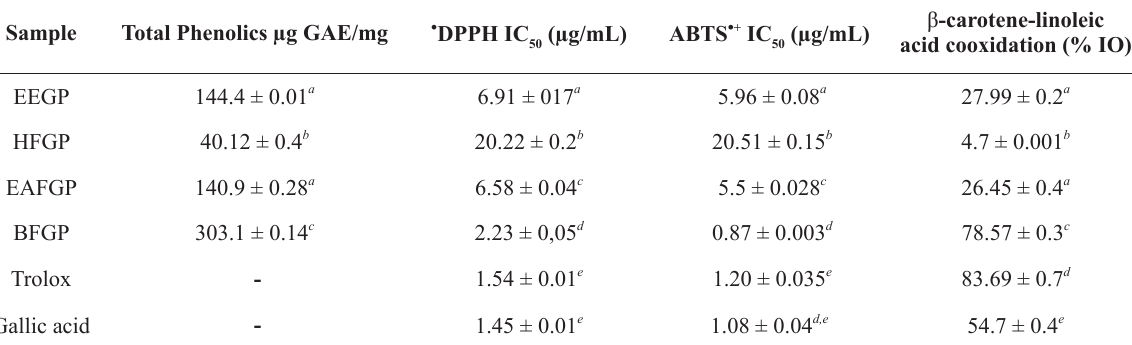
Total phenolics and antioxidant activities of the Melipona mondury geopropolis extract and fractions.